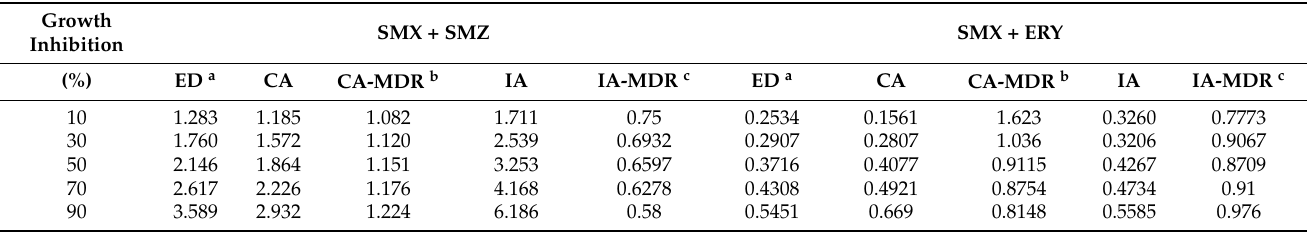
Table 2. Model deviation ratios (MDRs) values at different growth inhibitory concentrations for binary mixtures for R. subcapitata .